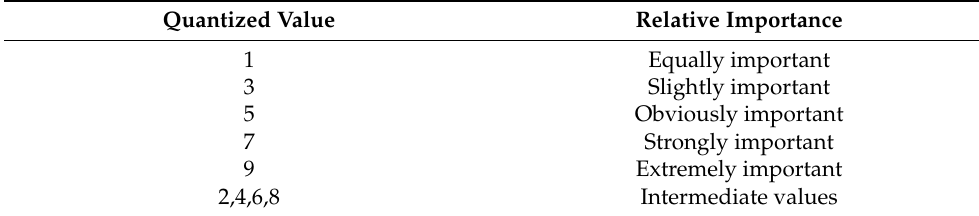
Table 3. Assignment of the Saaty1–9 scale method.